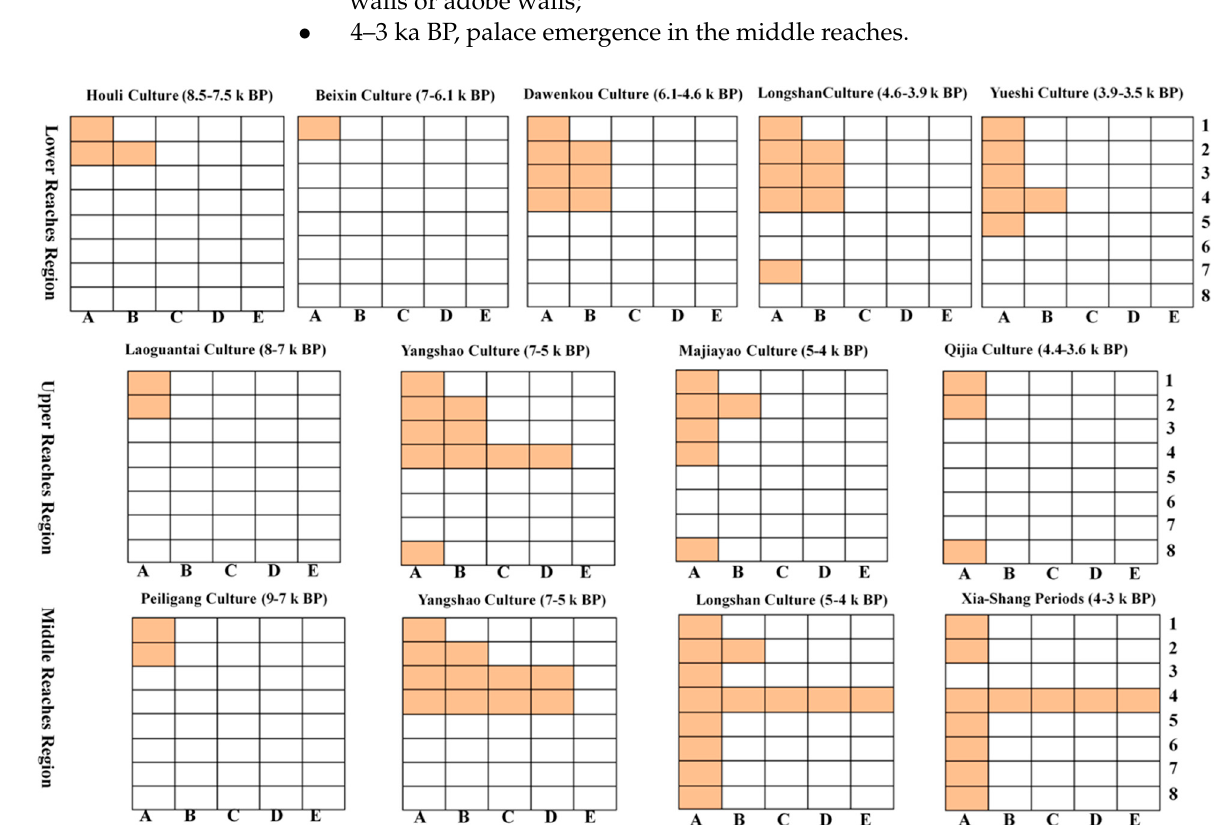
Figure 5. The house evolution in different areas (orange indicates the presence of such houses and white indicates the absence of evidence of these houses. The model code is the same as in Tables 1 and 2. The details are as follows: (A) small